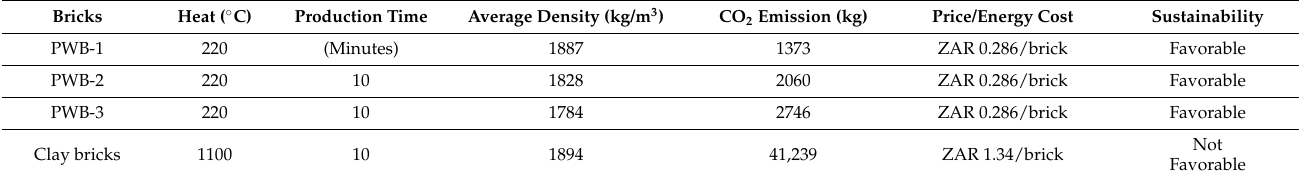
Table 3. Sustainable and embedded CO 2 analysis of